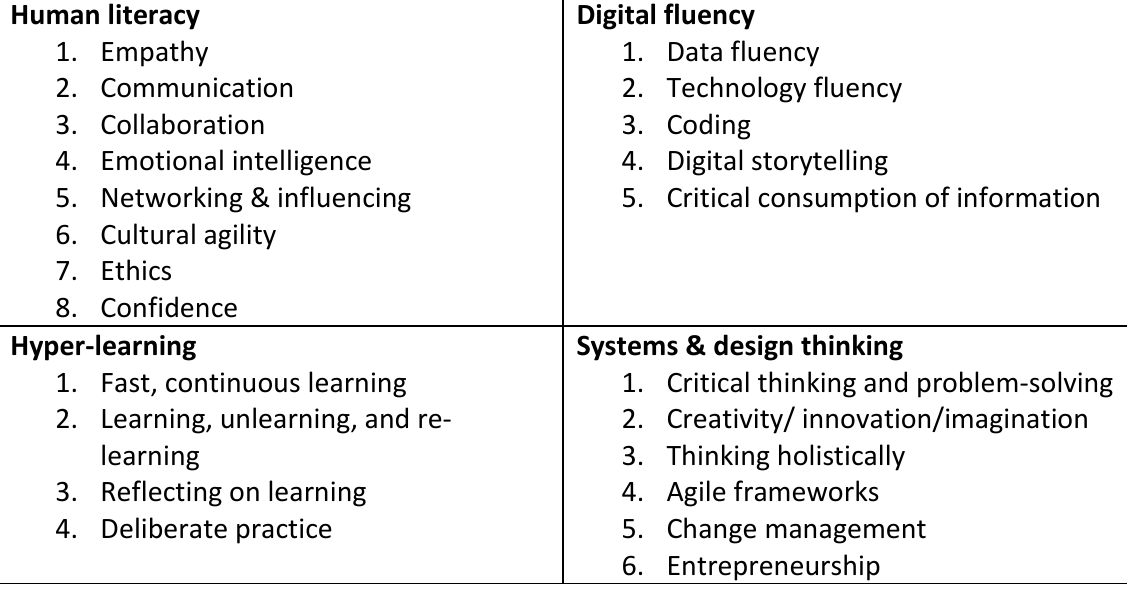
Table 1. 4IR Competencies Human